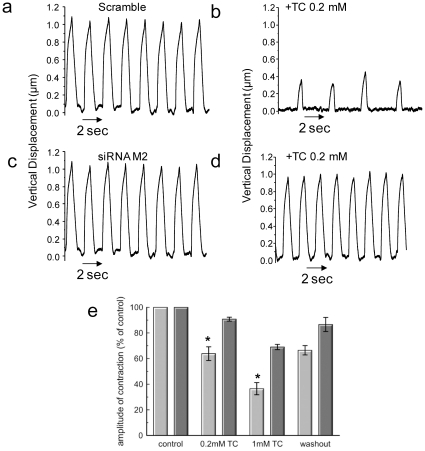
Muscarinic M2 receptor mediates TC effects of cardiac contraction.Representative measurement of the amplitude contraction of NRCM using SICM.(a-b) Scramble (non-targeting) siRNA NRCM showed regular contraction and alterations in rhythm and amplitude following TC treatment.(c-d) cardiomyocytes showed regular contraction following siRNA knockdown of M2 and TC treatment did not have an effect on rhythm of contraction. (e) Graph demonstrating the influence of adding 0.2 mmol/L and 1.0 mmol/L TC on the amplitude of contraction of non-targeting siRNA (grey bar) and siRNA-M2 knockdown (black bar) of NRCM. This is represented as a percentage (%) of the amplitude of contraction in cells prior to the addition of TC (designated controls). The extent to which the amplitude of contraction returns to normal after transfer of cells into TC-free medium is also shown. (* Control vs P<0.05); n = 6 observations).